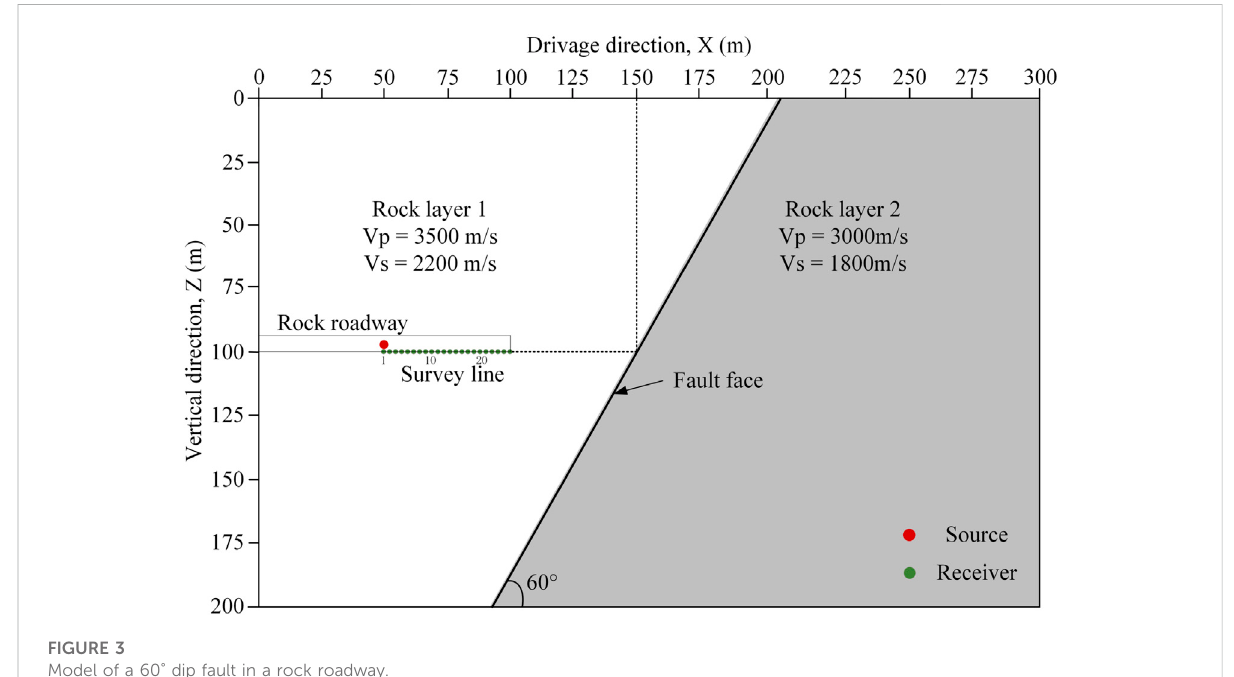
FIGURE 3 Model of a 60 ° dip fault in a rock roadway.